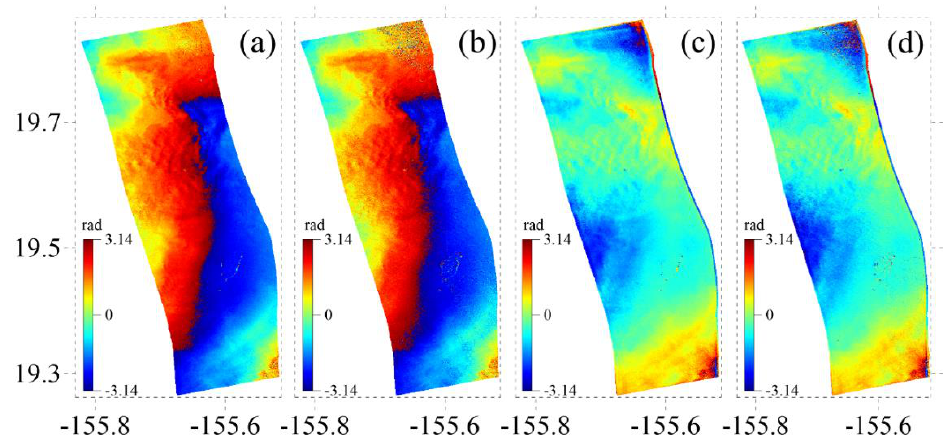
Figure 4. ( a ) and ( b ) are the initial D-Infs of the HH and HV polarizations, respectively. ( c ) and ( d ) Figure 4. ( a , b ) are the initial D-Infs of the HH and HV polarizations, respectively. ( c , d ) are the D-Infs are the D-Infs after ionospheric correction by the range split-spectrum method. after ionospheric correction by the range split-spectrum method.